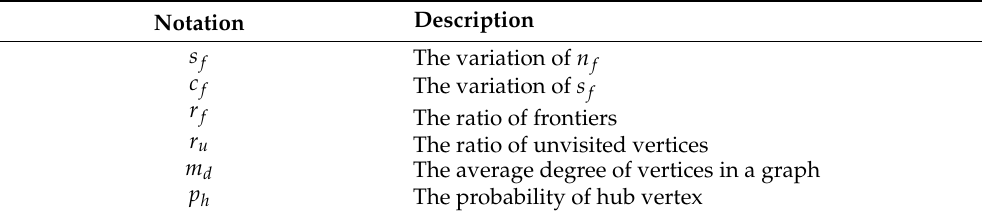
Table 1. Description of input features in